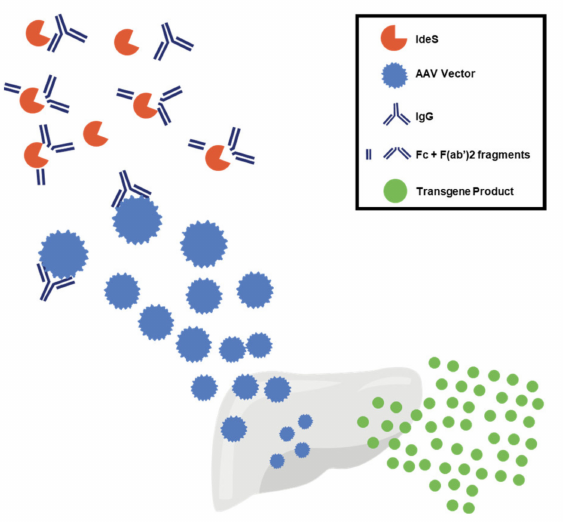
Figure 5. Mechanism of action of IdeS. IdeS is an IgG-degrading enzyme derived from Streptococcus pyogenes proposed as a strategy to overcome the limitation of neutralizing antibodies (NAbs) to AAV. IdeS is an endopeptidase that cleaves human IgG into F(ab (cid:48) )2 and Fc fragments, thus reducing the neutralization activity of anti-AAV antibodies. AAV, adeno-associated virus; IdeS, imlifidase; IgG, immunoglobulin G; Fc, fragment crystallizable region; F(ab (cid:48) )2, 2 antigen-binding (Fab)